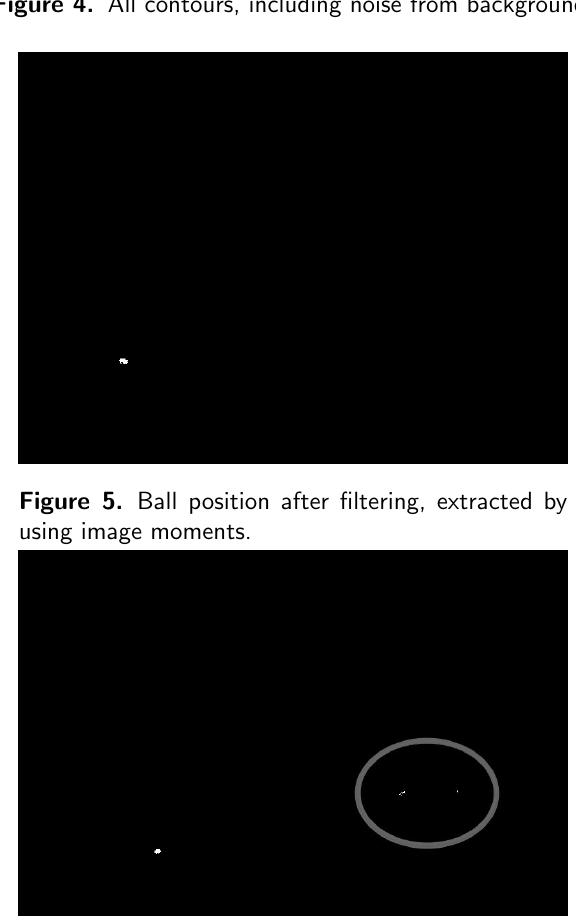
Figure 4. All contours, including noise from background.